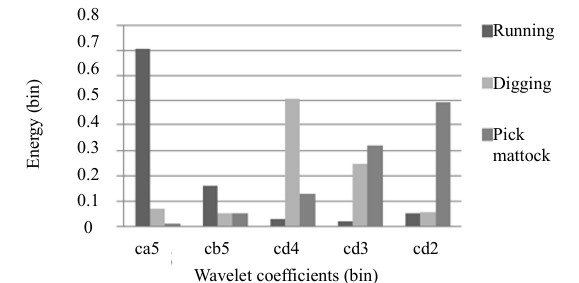
Fig. 7 Energy ratio of wavelet decomposition coefficient for intrusion signals.